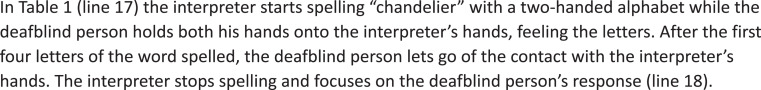
Backstage interaction between the interpreter and deafblind person.